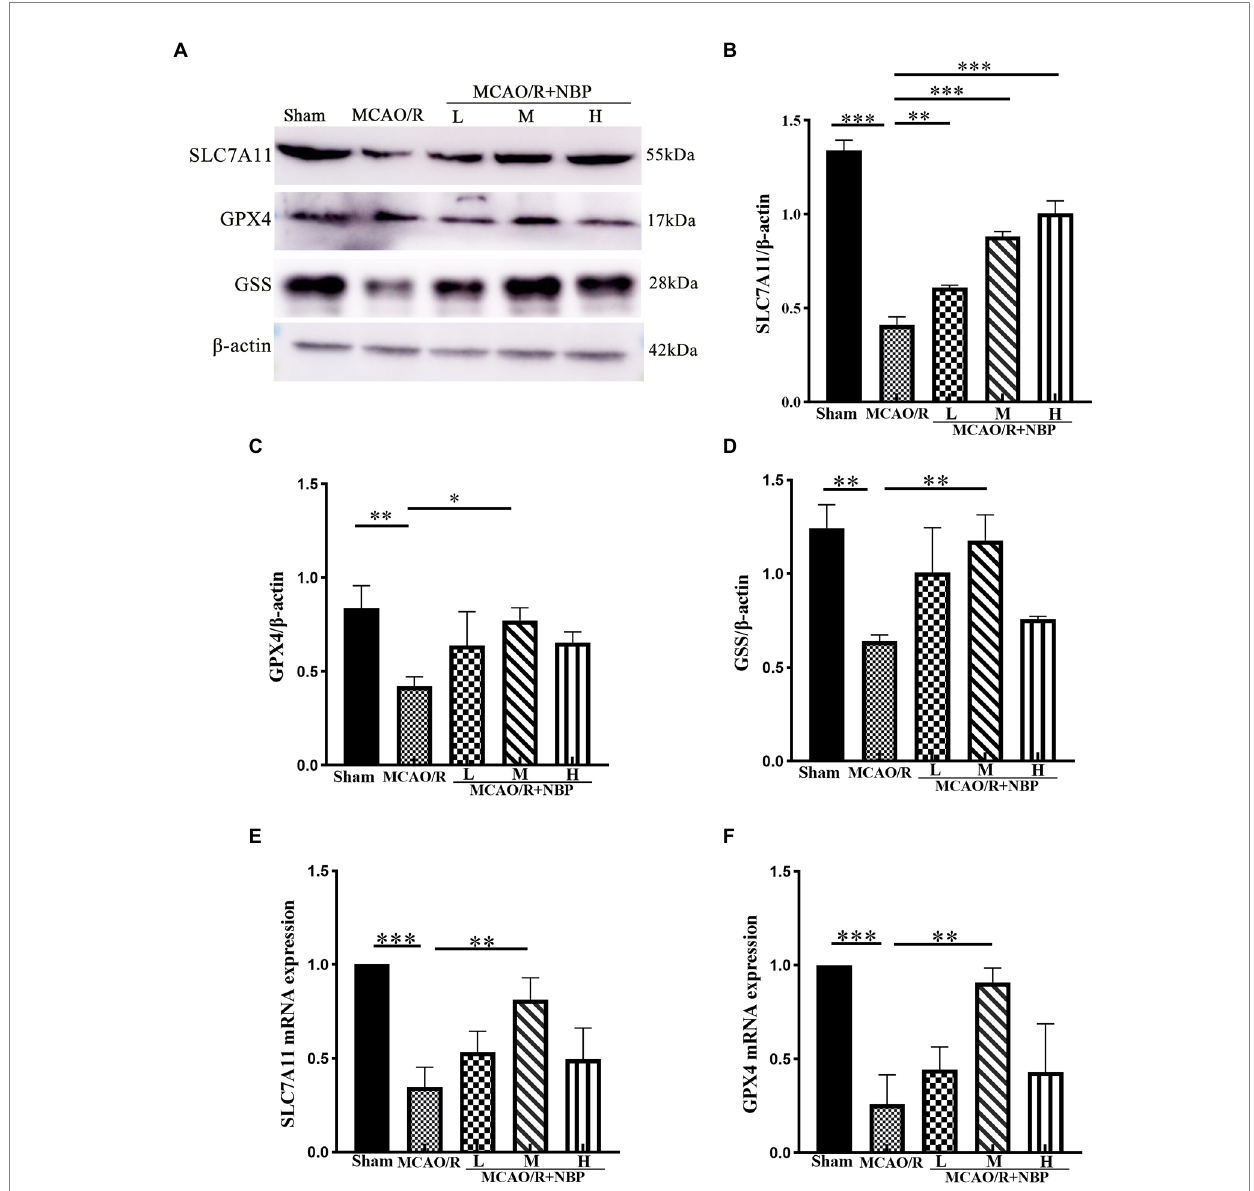
FIGURE 7 Western blot and PCR of ferroptosis-dependent SLC7A11/GSH/GPX4 signal pathway. (A) Representative western blot image of SLC7A11, GPX4, and GSS. (B–D) Quantification of SLC7A11, GPX4, and GSS. (E,F) PCR for SLC7A11, GPX4 levels within cerebral cortex tissues. PCR, Real-time polymerase chain reaction. * p < 0.05, ** p < 0.01, *** p < 0.001. The values represent the mean ± SD, n =